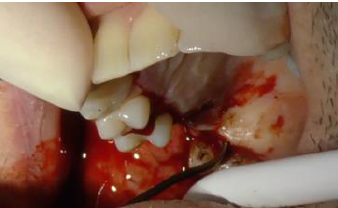
Figure 3. Detail of the design of the palatal flap.